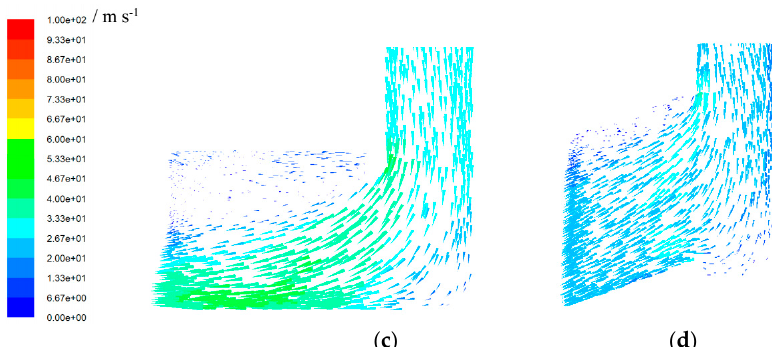
Figure 13. Outlet velocity vector of the outer covers of nozzle A and nozzle B. ( a ) nozzle A (100% load); ( b ) nozzle B (100% load); ( c ) nozzle A (30% load); ( d ) nozzle B (30% load).